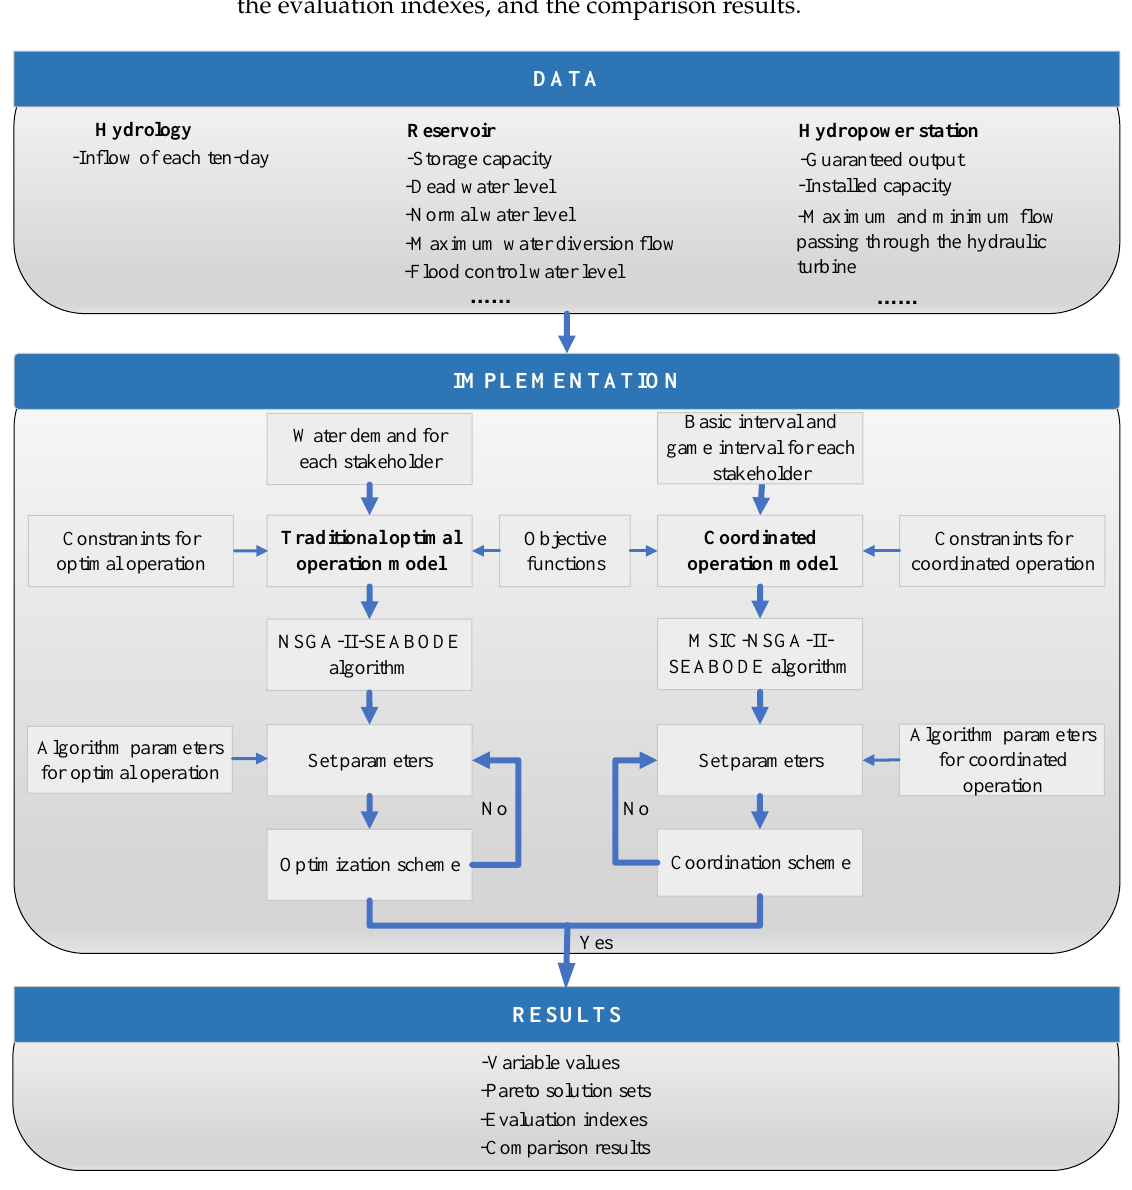
Figure 4. Application processes of models and algorithms.